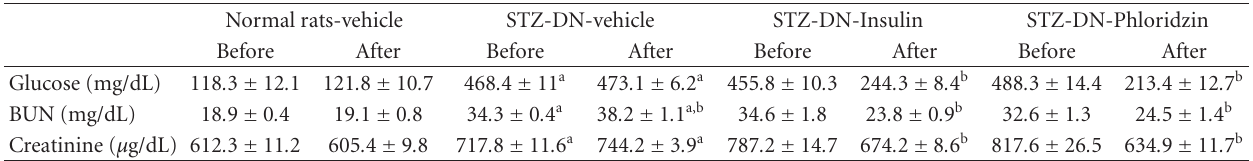
Table 1: Changes in blood glucose, BUN, and creatinine levels in streptozotocin-induced diabetic rats (STZ-DN) receiving repeated i.p.